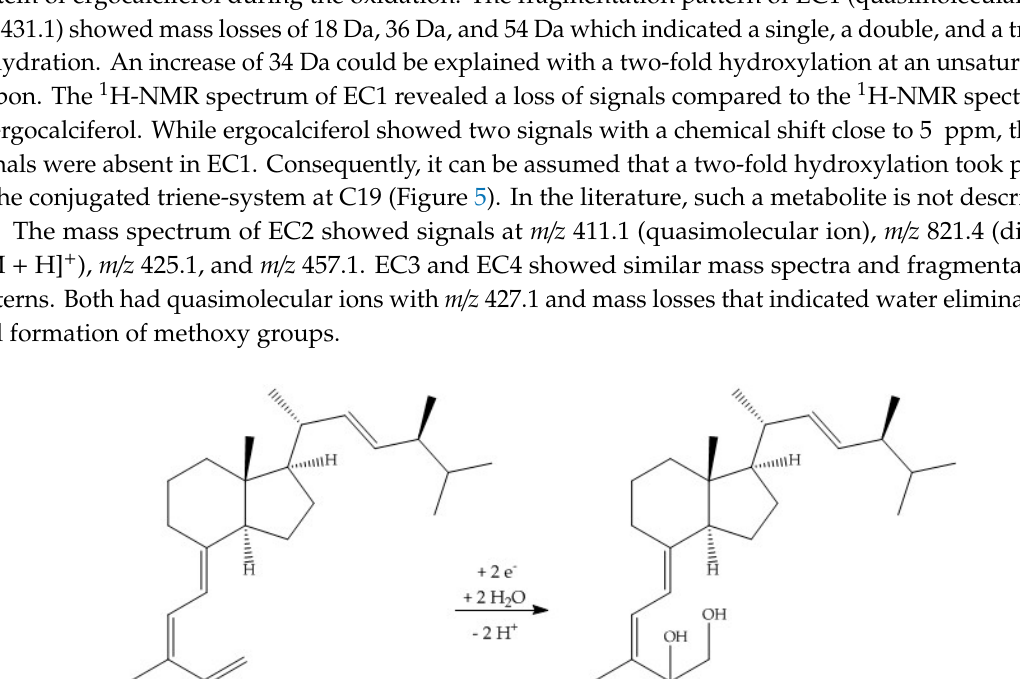
chromatogram 190–800 nm; 2: Ergocalciferol, oxidized, total ion chromatogram (TIC + All MS).